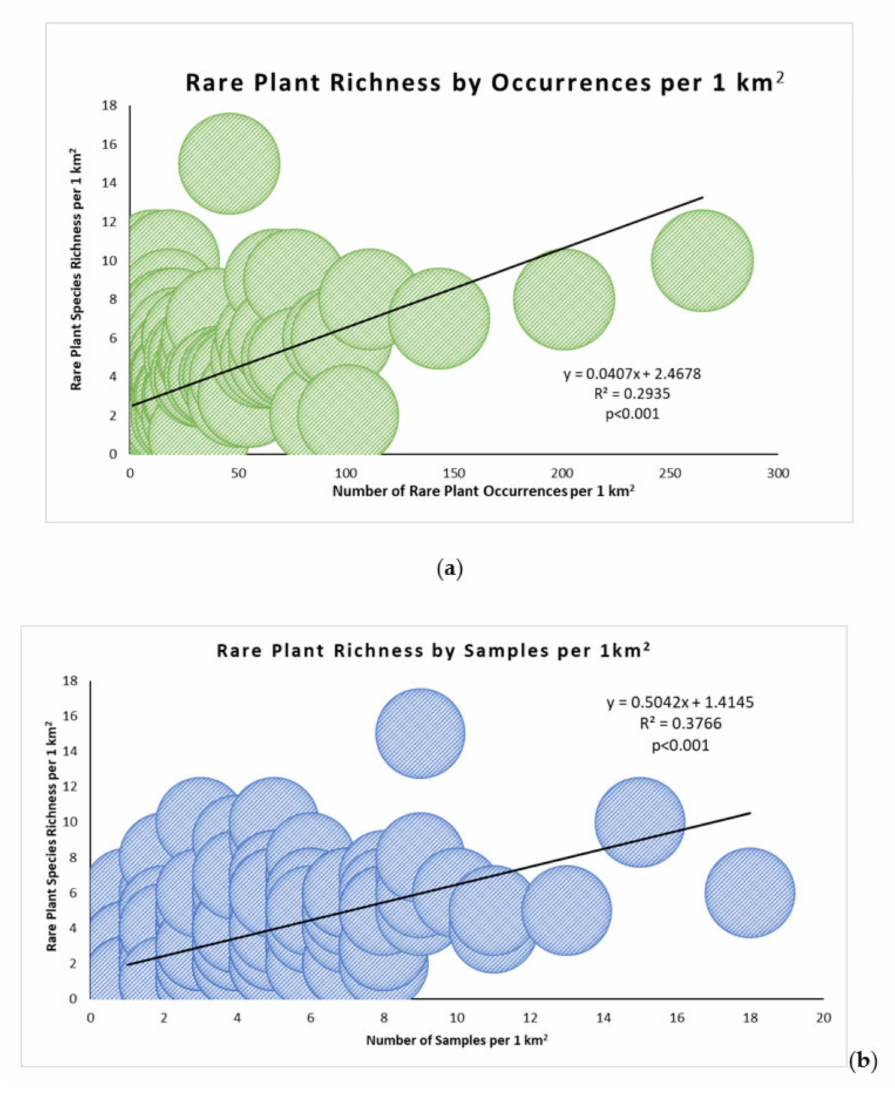
Figure 3. ( a ) Linear regression results of rare plant species richness by rare plant occurrences per one square kilometer in the NCC Reserve System. Each point represents the value of rare plant occurrences and rare plant species richness within a one square kilometer fishnet ( N = 274). Although significant, occurrences only explained twenty-nine percent of the variation in richness by area. This suggests that other factors, such as environmental heterogeneity, biotic factors, or soil characteristics, may be driving some areas to be diverse hotspots of rarity. ( b ) Linear regression results of rare plant species richness by number of samples per one square kilometer in the NCC Reserve System ( N = 274). Sampling e ff ort explained 37% of the variation in richness by